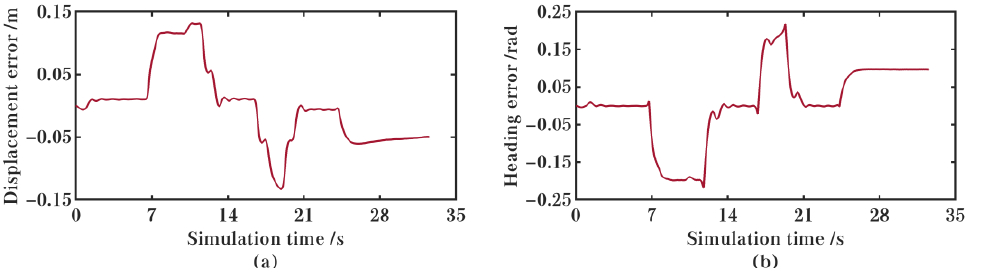
Figure 15. The errors of the simulation when tracking the complex reference path: ( a ) displacement error; ( b ) heading error.